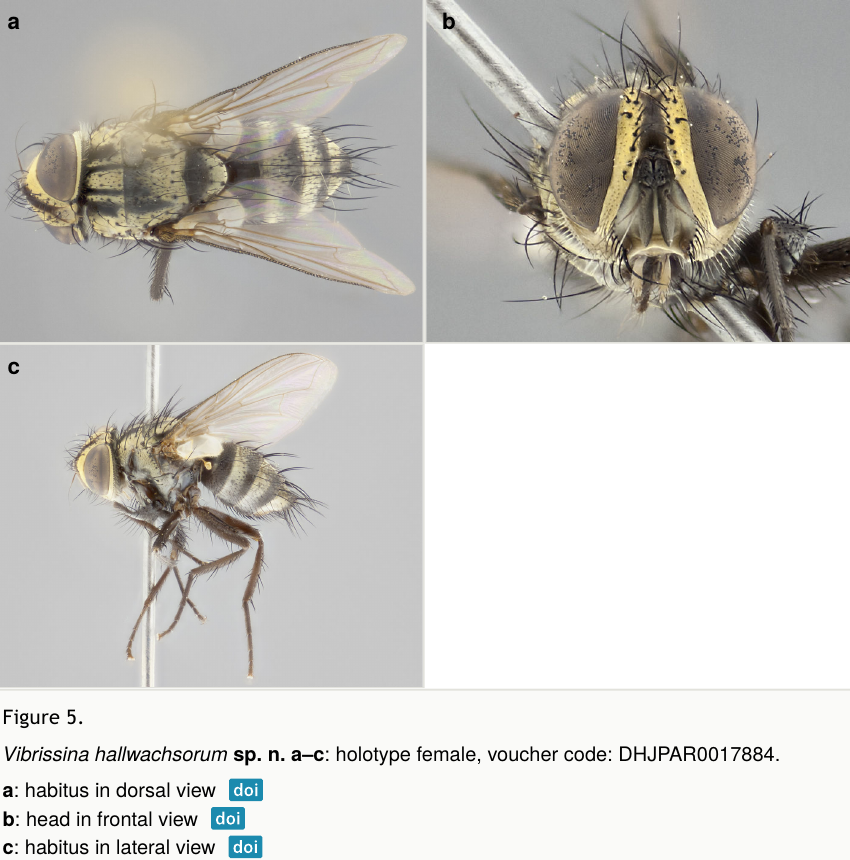
Distribution Costa Rica, ACG, Prov. Guanacaste, cloud forest, at 1090m. Ecology Hosts : reared once from a larva of the saw fl y Waldheimia interstitialis (Cameron) (Tenthredinidae) feeding on the leaves of Hamelia patens Jacq. (Rubiaceae).